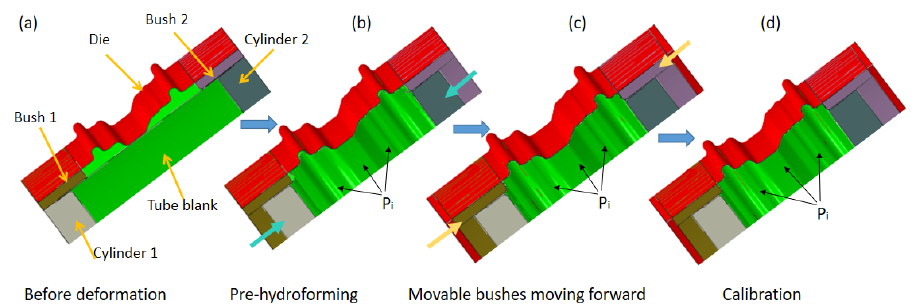
Figure 8. The process design with the conventional hydroforming process: ( a ) before deformation, ( b ) pre-hydroforming, ( c ) movable bushes moving forward, and ( d ) calibration. ( b ) pre-hydroforming, ( c ) movable bushes moving forward, and ( d )